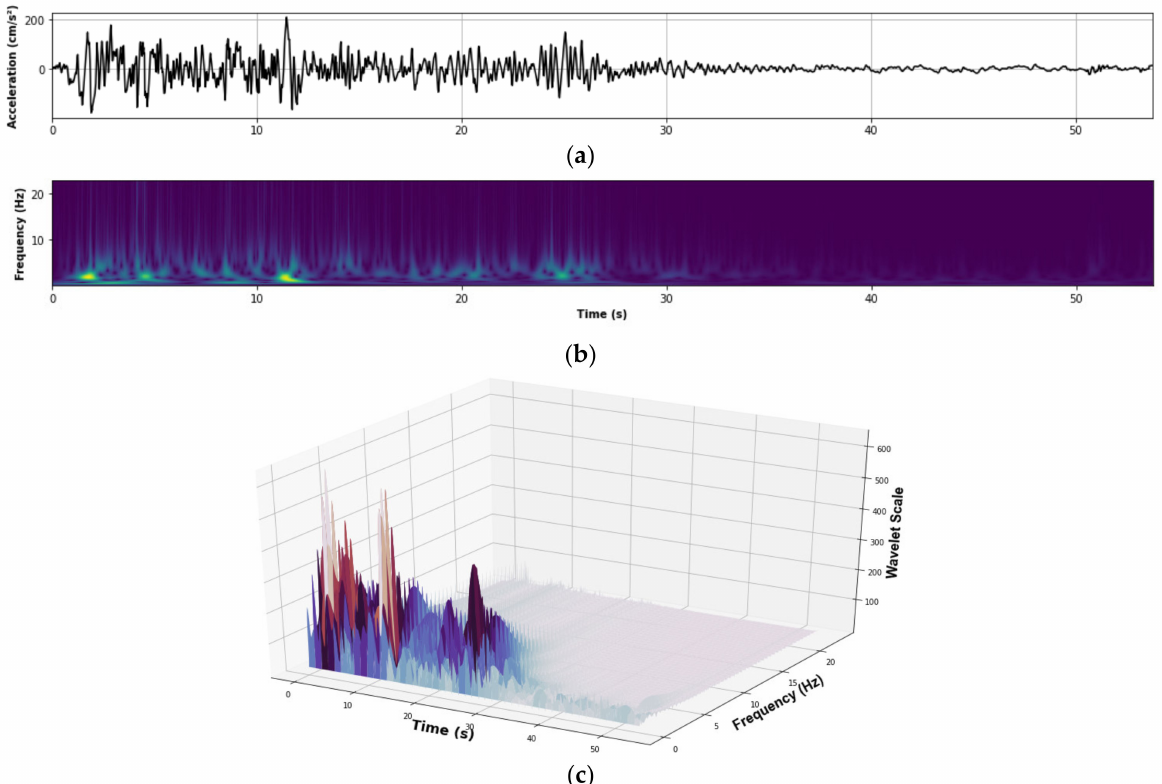
Figure 7. ( a ) Acceleration wave; ( b ) 2D wavelet spectrum; ( c ) 3D wavelet